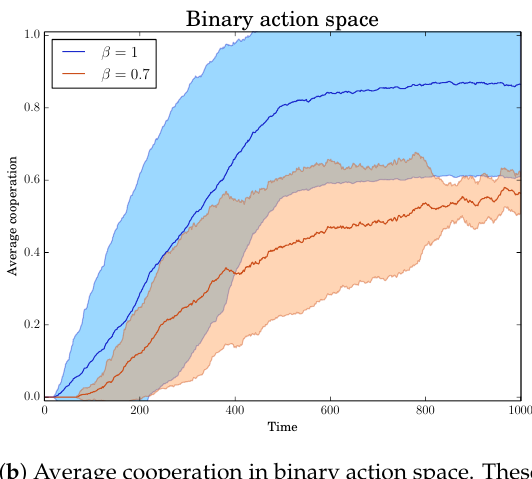
Figure 3. The figure summarizes the average level of contributions in continuous and binary action spaces. The average is shown as a function of time for the voluntary contribution game with meritocratic matching with homogeneous endowments in four different cases: perfect and imperfect observations for continuous ( a ) and binary ( b ) action spaces. When the matching mechanism is implemented without noise ( β = 1, blue lines in ( a , b )), we observe high levels of cooperation in both cases. On the other hand, when the matching mechanism is implemented with partially-noisy observations β = 0.7, orange lines in ( a , b ), the result depends on the strategy space of the game: for a continuous action space ( a ), we observe a very low percentage of average contributions, while for a binary action space ( b ), we see a higher level of cooperation. The blurred areas around the lines represent the 95% confidence interval. The simulations were obtained for the following set of parameters: s = 4, R = 0.5, EN = 200, p = 0.99. The simulations for the binary action space are obtained with a lower value for the rationality parameter in the logit function in order to speed up convergence and with a higher number of agents to reduce the